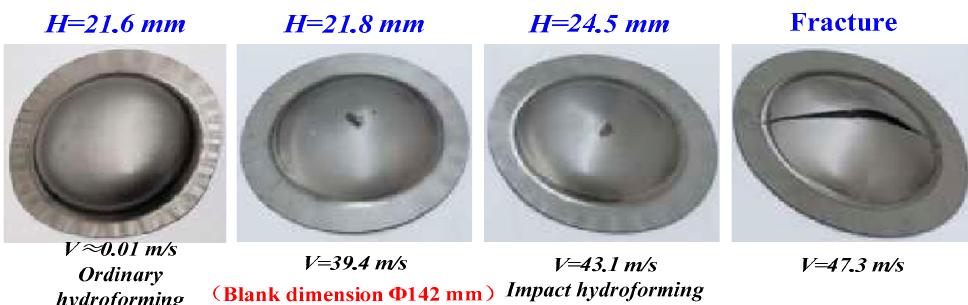
Figure 8. Comparison of the bulging heights of Ti-6Al-4V alloy sheets with different liquid impacting speeds at room temperature [76]. Reprinted with permission from Ref. [76]. Copyright 2021.